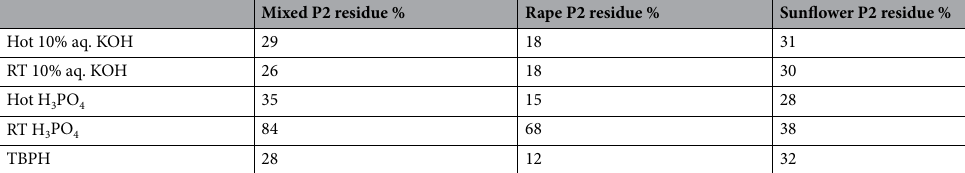
Table 3. Ratio of the dry matter content of bee pollen samples P1-purified by Soxhlet extractions and an aqueous was, before and after different P2 purifications (removal of the intine wall and the cellular debris). Classical protocols and a method using TBPH are